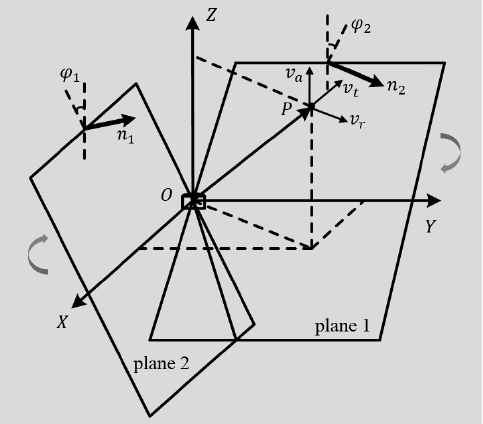
Figure 5. Transmitter model and speed decomposition.